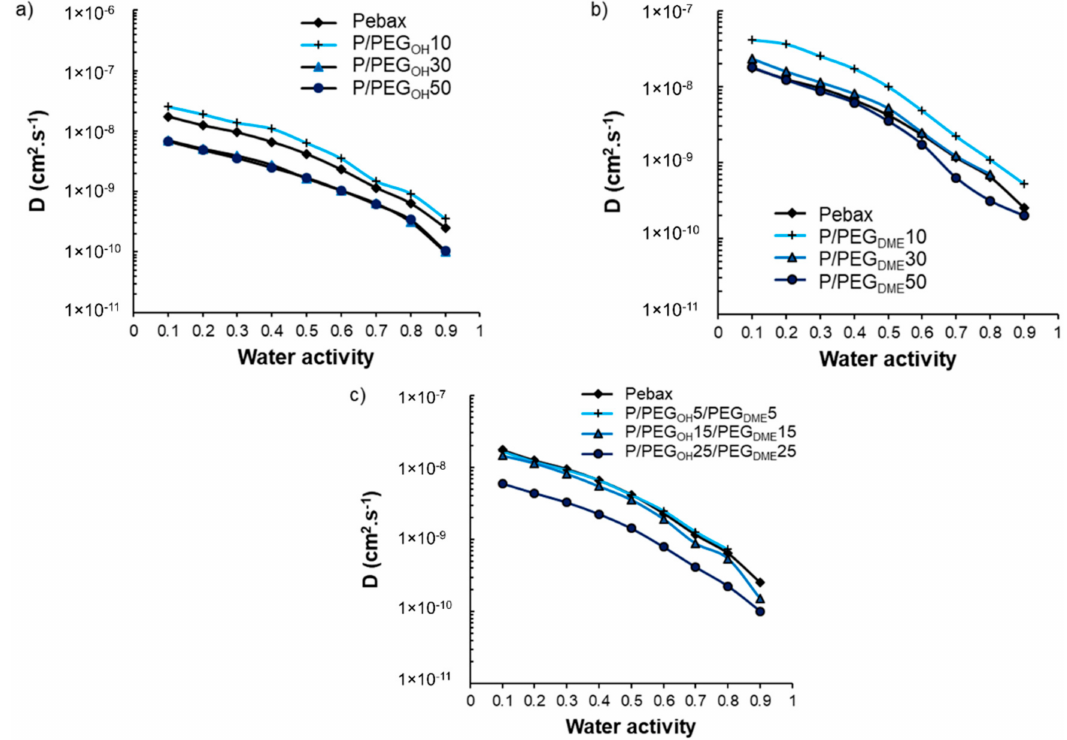
Figure 12. Evolution of the diffusion coefficient as a function of the film composition and water activity for Pebax ® /PEG OH blends ( a ), Pebax ® /PEG DME blends ( b ), and Pebax ® /PEG OH /PEG DME blends with a 50/50 wt.% PEG OH /PEG DME ratio ( c